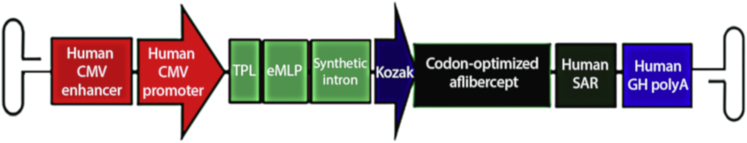
Design of the Aflibercept Expression Cassette (C11)The aflibercept transgene expression cassette is flanked by AAV2 inverted terminal repeats (ITRs). The C11.CO.aflibercept cassette includes regulatory elements including the human cytomegalovirus (CMV) immediate-early enhancer and promoter, an adenovirus tripartite leader sequence (TPL) followed by an enhancer element from the major late promoter (eMLP), a synthetic intron, and a Kozak sequence driving expression of aflibercept. The cDNA of aflibercept is followed by a human scaffold attachment region (SAR) and the human growth hormone (GH) polyadenylation site. Aflibercept is a recombinant chimeric protein consisting of the vascular endothelial growth factor (VEGFA) binding portion of human VEGFR-1 (domain 2) and VEGFR-2 (domain 3 or KDR) fused to the Fc portion of human IgG1 immunoglobulin.